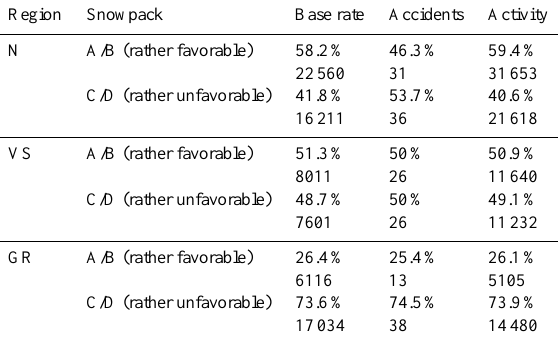
Table 2. Frequencies for the snowpack classes rather favorable and rather unfavorable for the main regions. No data for region S are shown, as this region had rather incomplete data (data covering only 70% of the time) and rarely any accidents. Relative and absolute frequencies are given.